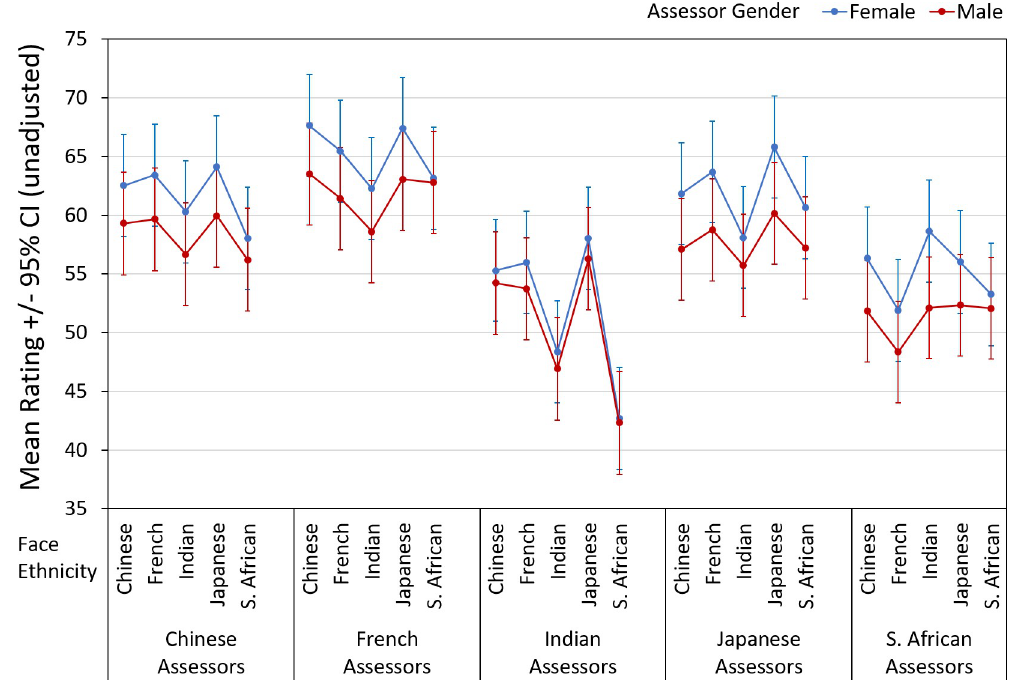
Fig 5. Assessments of facial images, by participant (“face”) ethnicity, assessor ethnicity and gender for health.